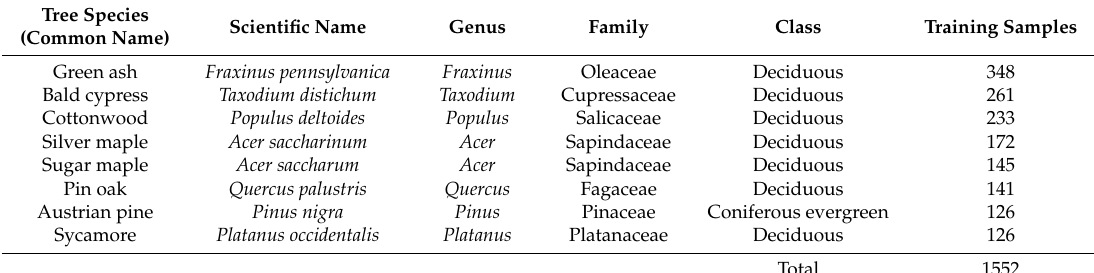
Figure 1. Study area located at Forest Park in St. Louis, MO, USA. The red border indicates the boundary of the park. Table 1. List of tree species and number of training samples collected within the study area.